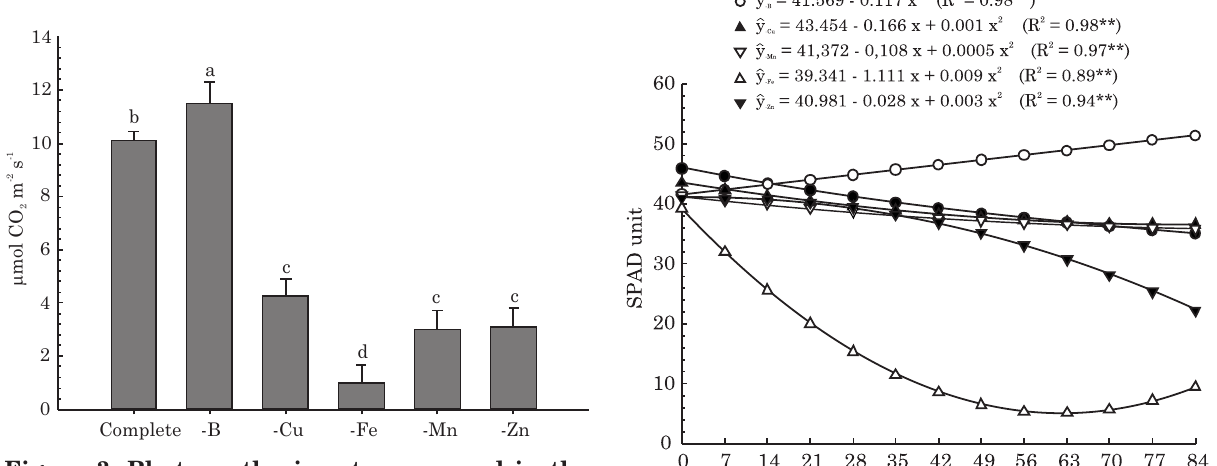
Figure 3. Photosynthesis rate measured in the middle lobe of the third and fourth recently expanded leaves of physic nut grown in complete nutrient solution and in absence of B, Cu, Fe, Mn, and Zn, 105 days after the start of the treatments. Means followed by the same letter are not significantly different by Tukey’s test at